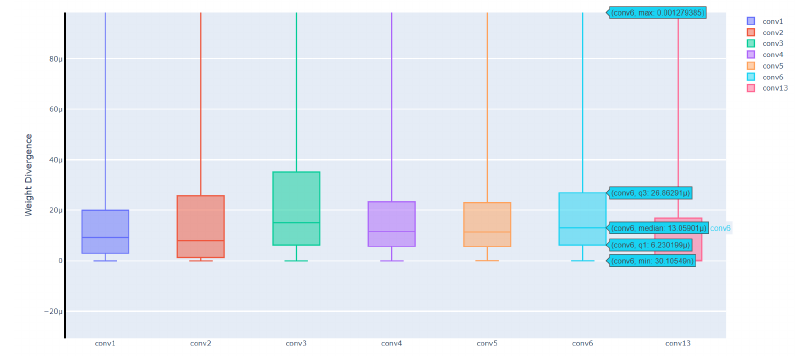
Figure 15. The single-weight differences in each